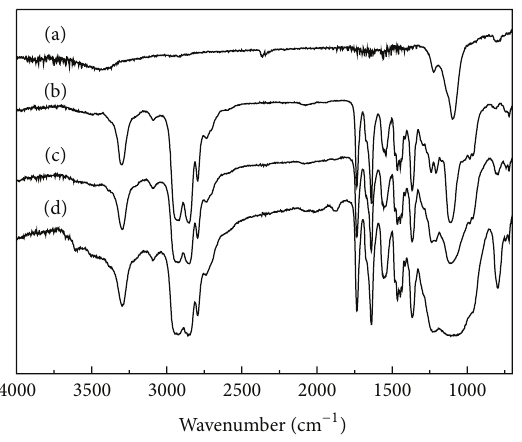
Figure 1: FT-IR spectra of (a) ZSM-5, (b) PEBA, (c) PEBA/ZSM-5- 10, and (d)